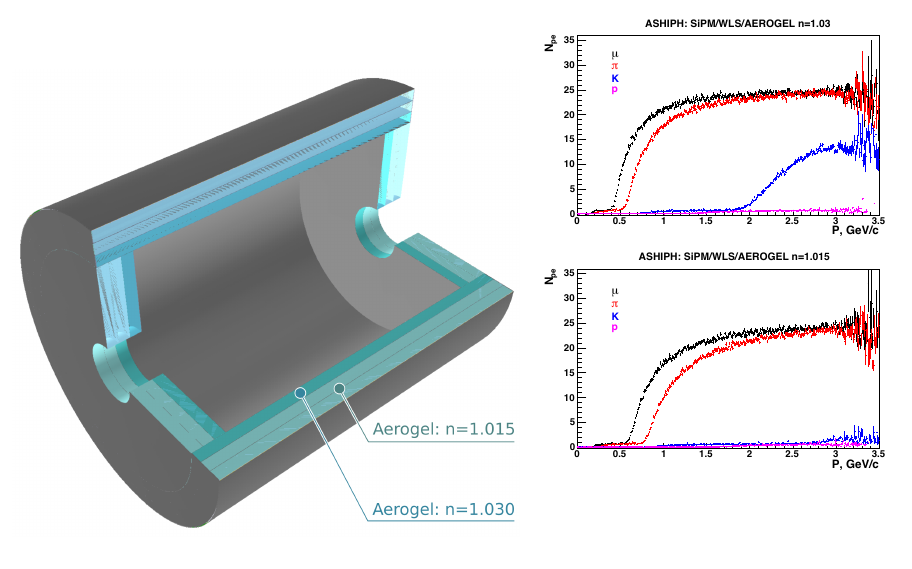
Figure 7. Dependences of the detected photons number in the ASHIPH system on momentum for di ff erent particles: muons (black), pions (red), kaons (blue), protons (magenta). The signals for the ASHIPH sys- tem based on aerogel with n = 1.030 are pre- sented on top plot and for ASHIPH system based on aerogel with n = 1.015 — on bottom